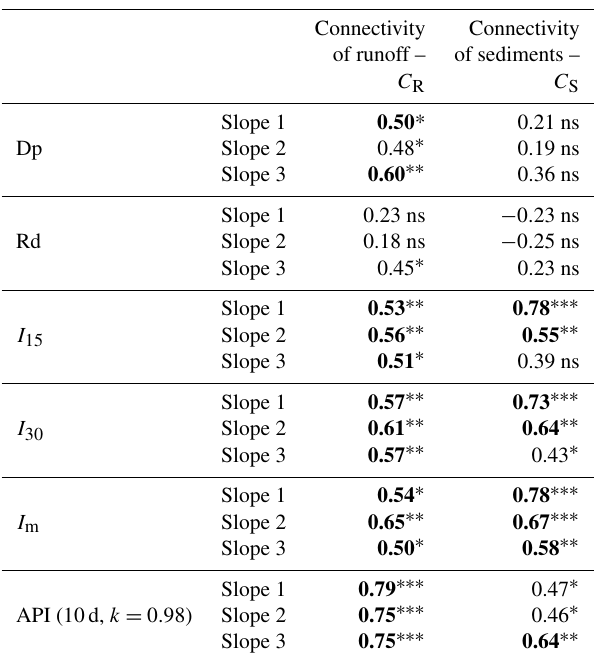
Table 2. Spearman’s R correlations between the event characteris- tics and conditions (storm depth, Dp; rainfall duration, Rd; 15 and 30min maximum rainfall intensity, I 15 and I 30 ; mean rainfall in- tensity, I m ; and antecedent precipitation index, API) and the con- nectivity of runoff and sediments for the three experimental